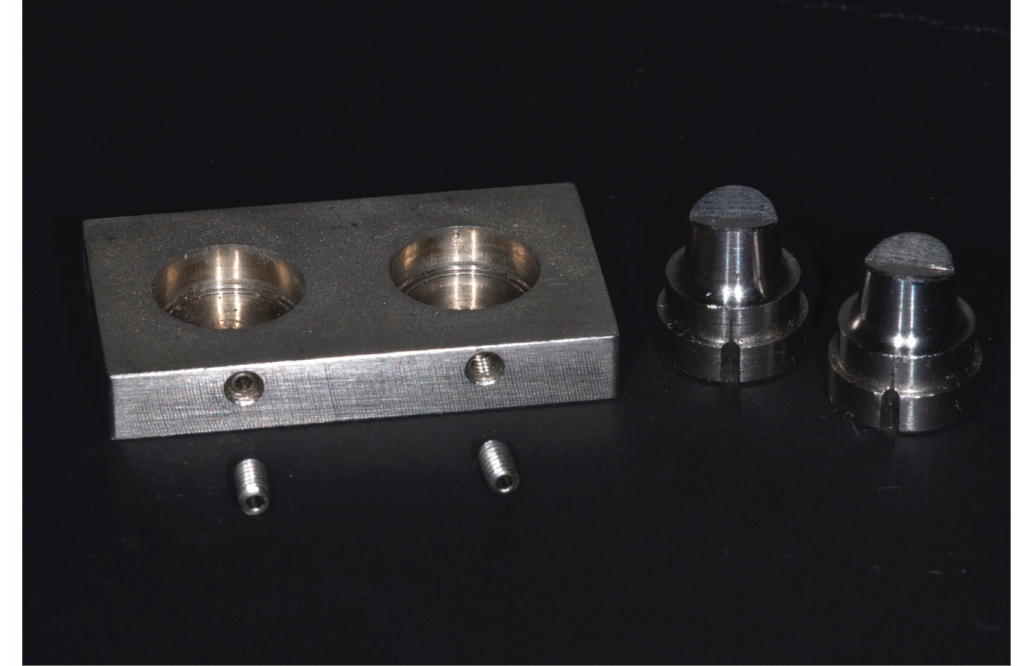
Figure 1. Master die components (platform, screws and abutments) of conventional frameworks.